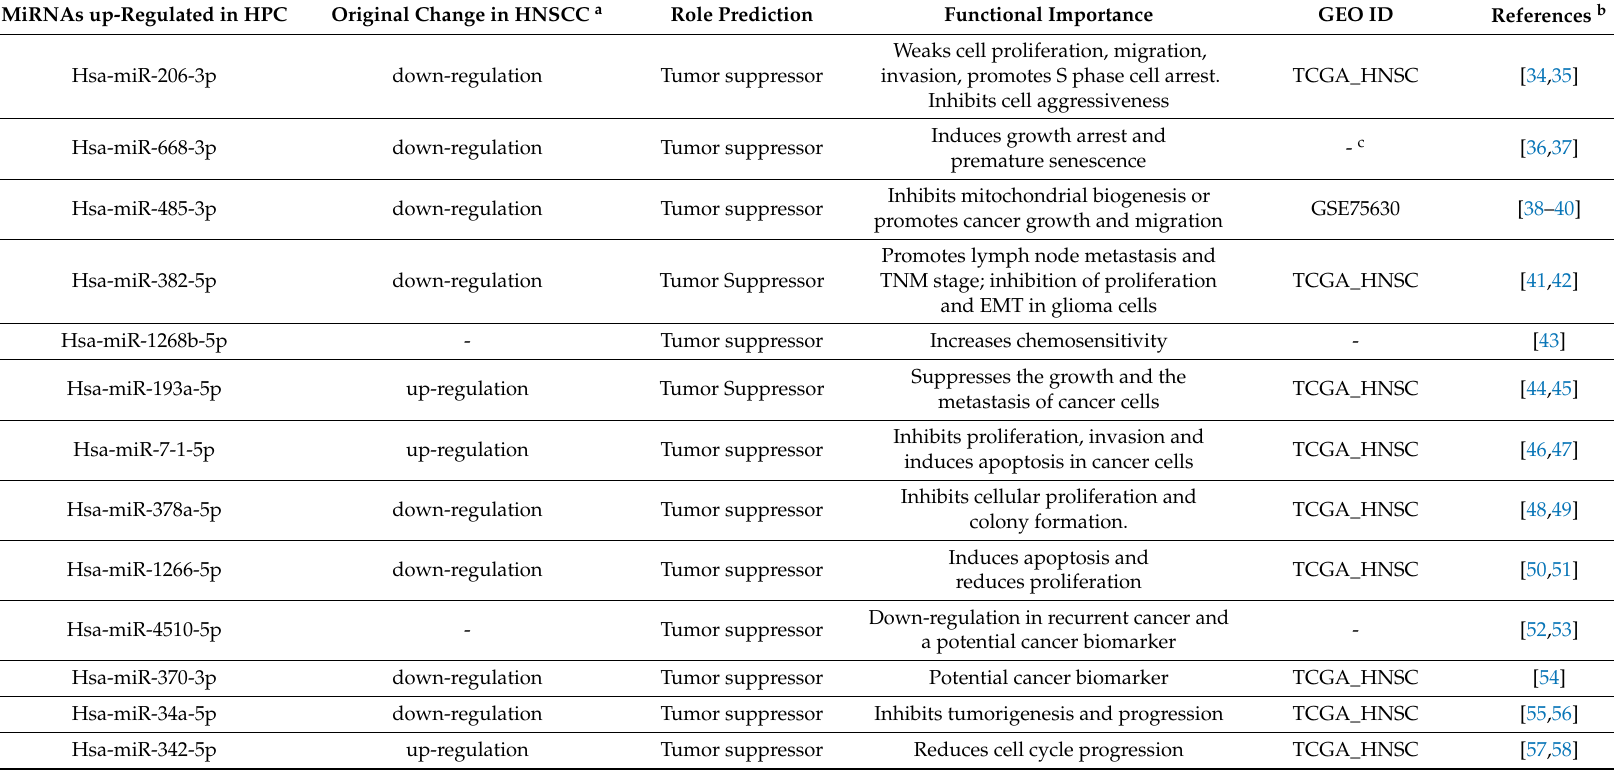
Table 2. Functional prediction algorithm for microRNAs of human hypopharyngeal tumor model up-regulated by 188